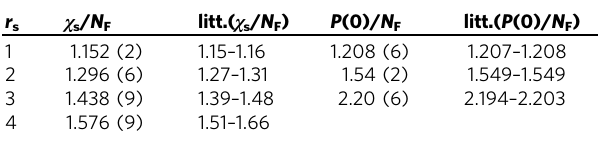
First column χ s = χ s ( q = 0, ω = 0) is the spin susceptibility, here normalized by the density of states at the Fermi level ( N F ), as computed by the current method. The second column shows the range of previous estimations from the literature 37 . P (0) ≡ P ( q = 0, ω = 0) is the static uniform charge polarization as obtained by this method. Unfortunately both CFS and VCCFS methods approach the converged value from below, hence extrapolation to N = ∞ is needed, which leads to much larger error bar in our calculation. The fourth column lists previous DMC results, extracted from two different correlation energy ansatzes proposed in refs.